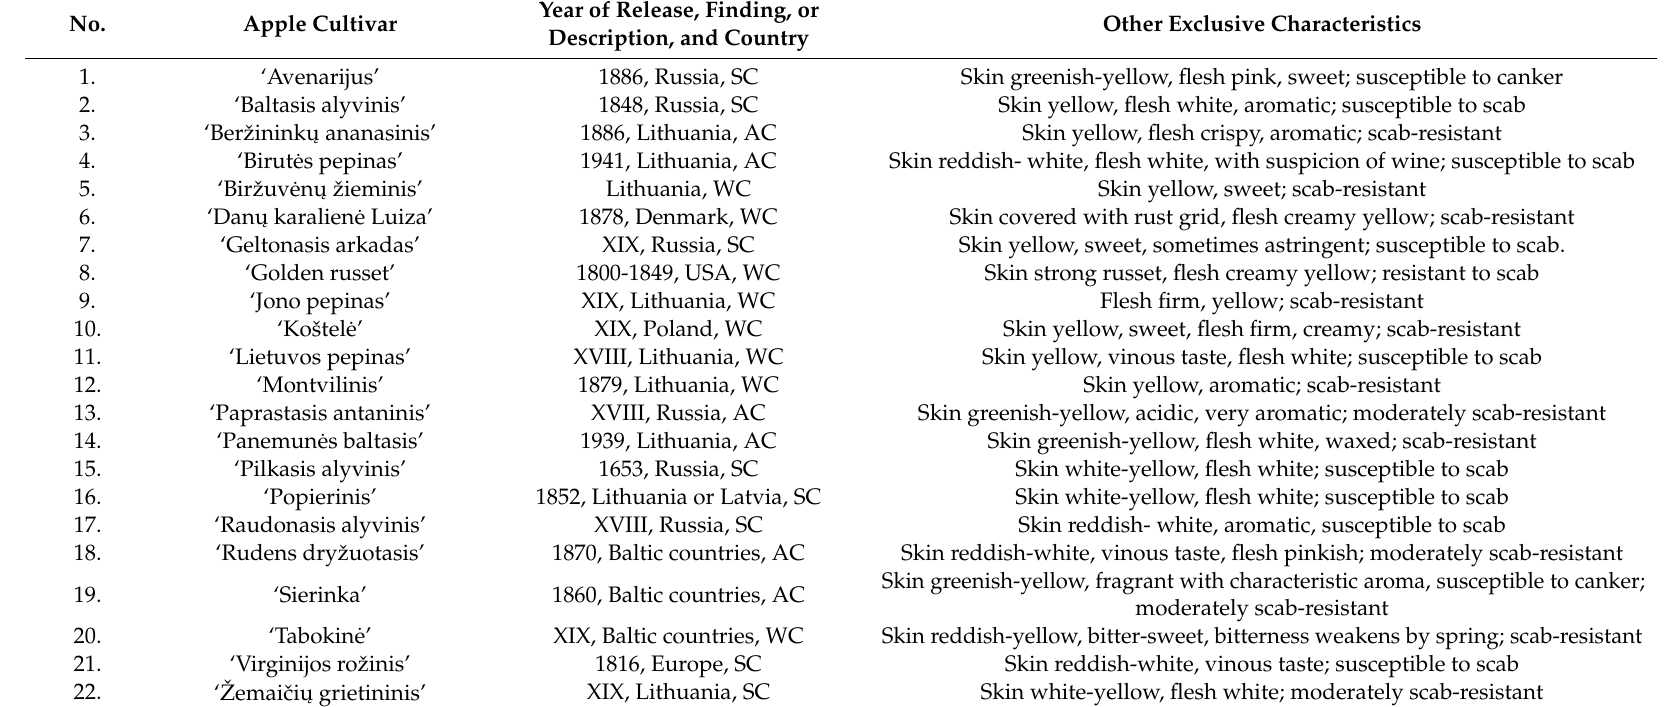
Table 1. Origin and properties of the heirloom apple cultivars of Lithuania